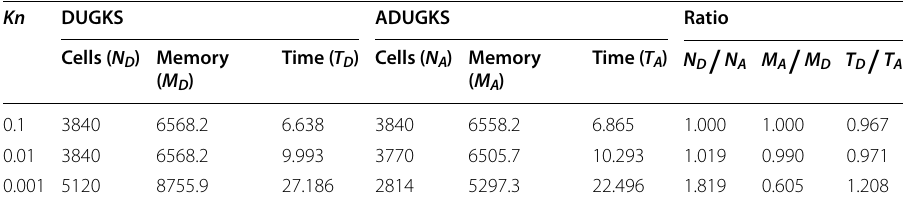
Table 2 Number of DUGKS cells, memory consumption (MByte) and computational time (hours) of different methods for flow around a circular cylinder with different Knudsen numbers Kn DUGKS